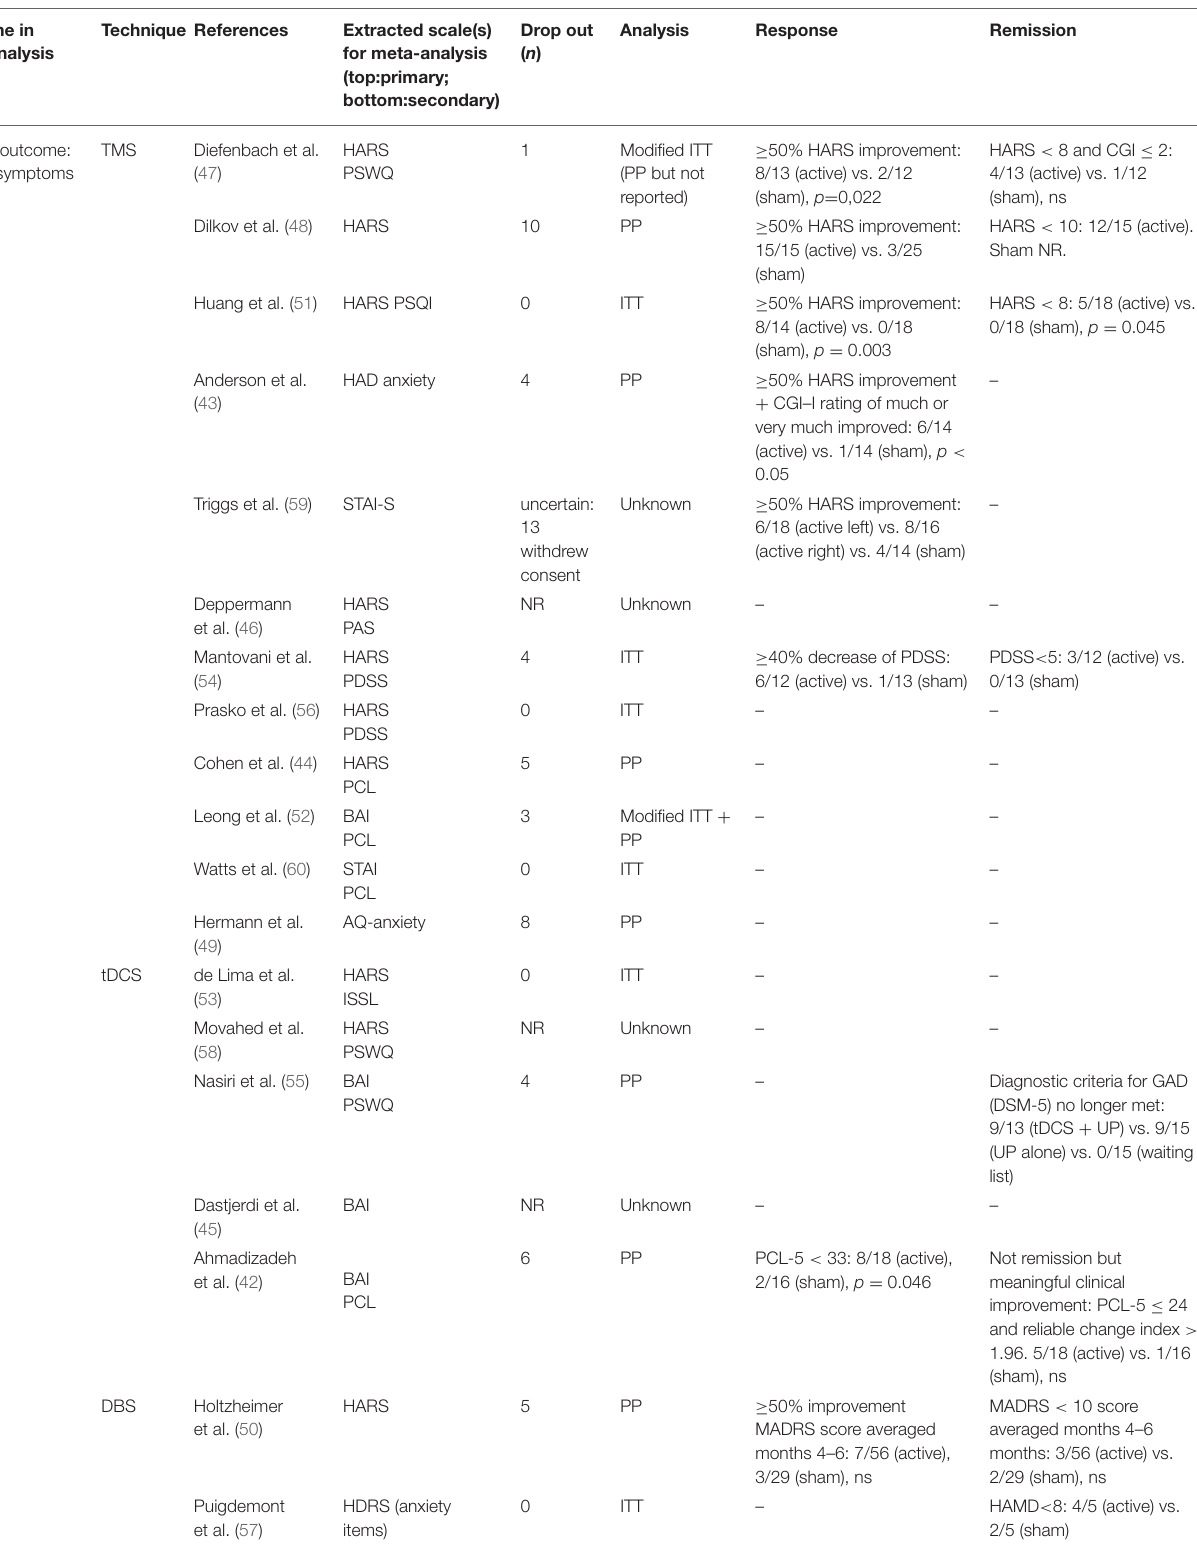
TABLE 2 | Characteristics of included studies (extracted scales, drop out, analysis, response and remission rates). Outcome in